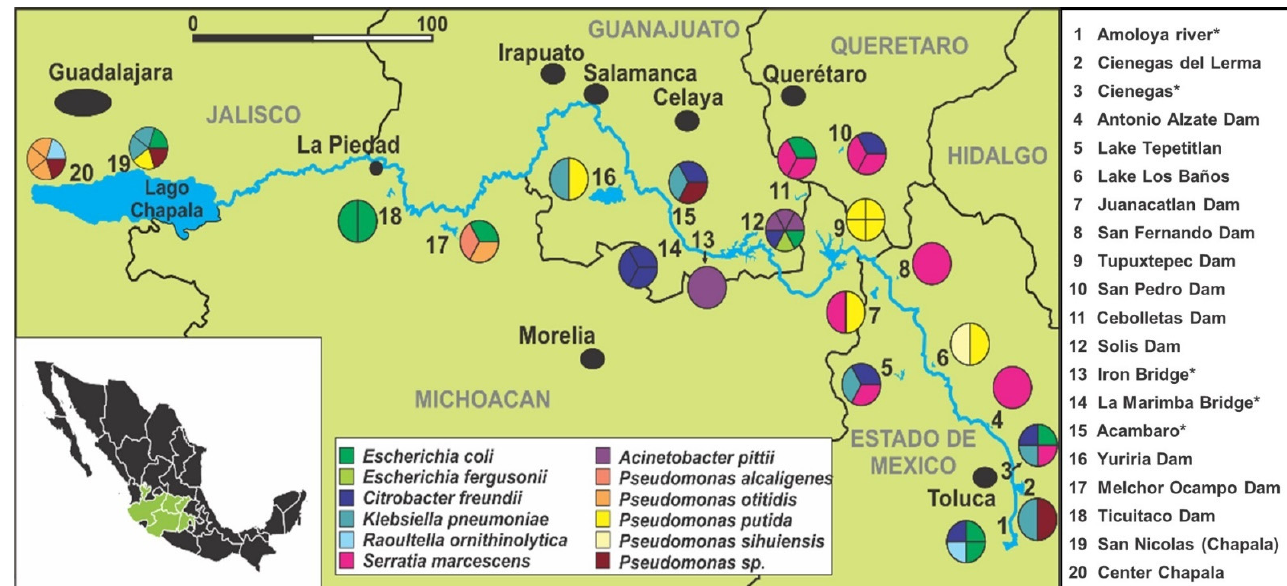
Figure 1. Frequency (%) of ß-lactam-resistant-Gram-negative bacteria isolated from the Lerma River basin according to the sampling location (1 through 20).